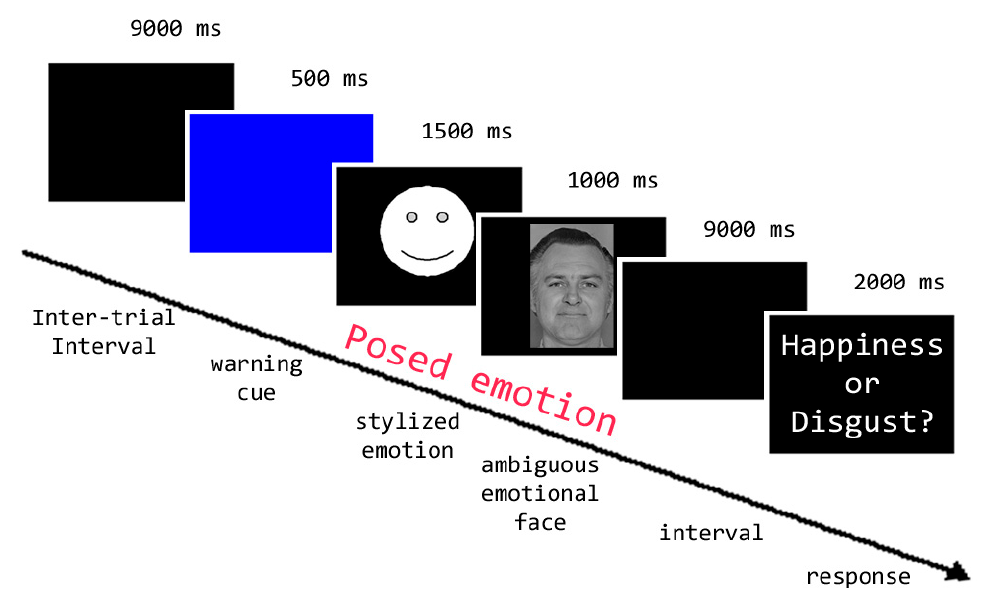
Figure 1. Experimental protocol for the fMRI session.